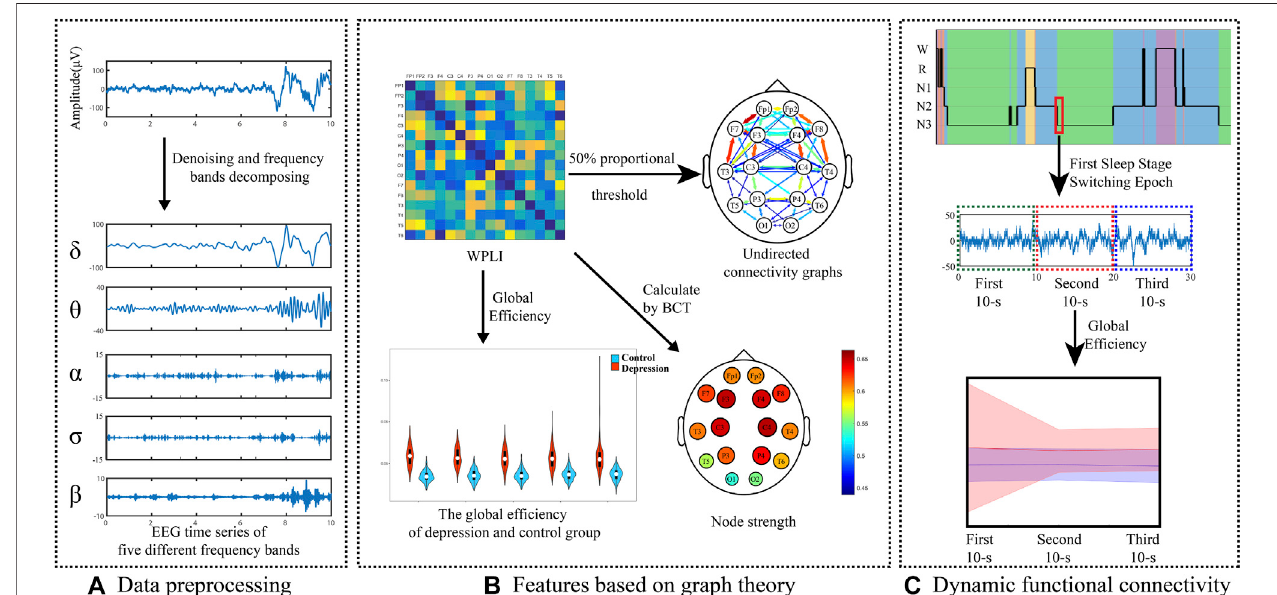
FIGURE 1 | Framework of this study.